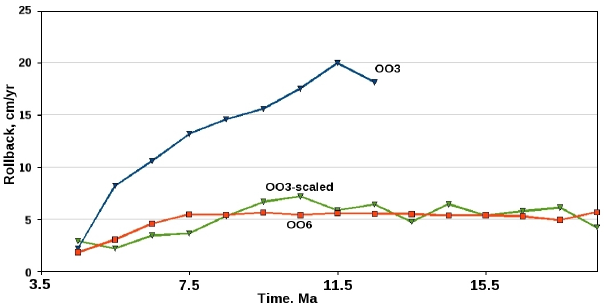
Fig. 8. Evolution of the speed of rollback for two models: model OO3 with aspect ratio 3:1 (blue line), and model OO6 with aspect ratio 6:1 (red line) and scaled speed of rollback for the model OO3 with aspect ratio 3:1 (green